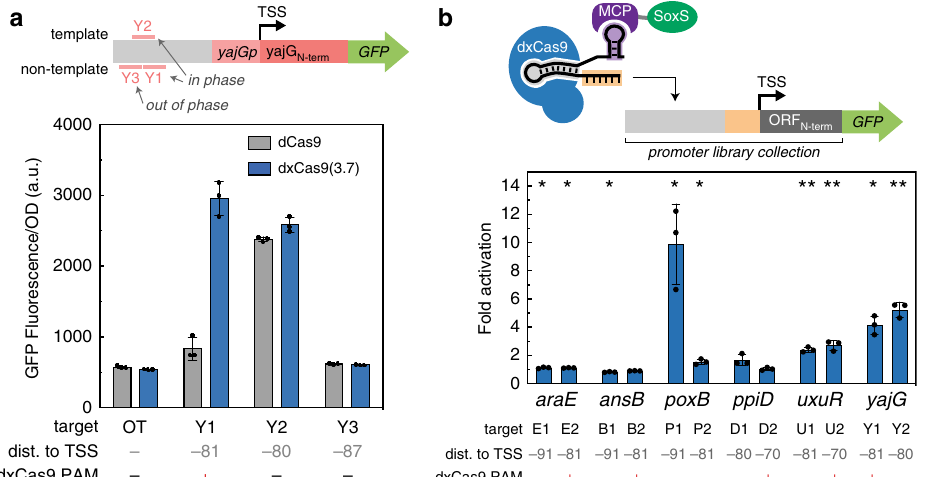
Fig. 6 Predictive rules enable endogenous activation. a CRISPRa using dCas9 and dxCas9(3.7) was targeted to a yajG reporter plasmid from the E. coli promoter collection 36 . Three scRNA target sites were selected; two sites were located at the positions where CRISPRa was most effective (Y1 – 2), and one was located out of phase (Y3). A negative control (OT) expressing an off-target scRNA (J306) was included. b CRISPRa was targeted to yajG and fi ve additional promoters from the E. coli promoter collection (Supplementary Methods). Two scRNA sites located at the positions where CRISPRa was most effective were targeted for each gene using dxCas9(3.7). Samples are arranged by baseline expression of the target genes, in ascending order left to right. Fold activation indicates the median fl uorescence of strains relative to an off-target control (J306). Values a and b represent the average±standard deviation calculated from n = 3 biologically independent samples. Stars indicate a statistically signi fi cant difference from the off-target control using a